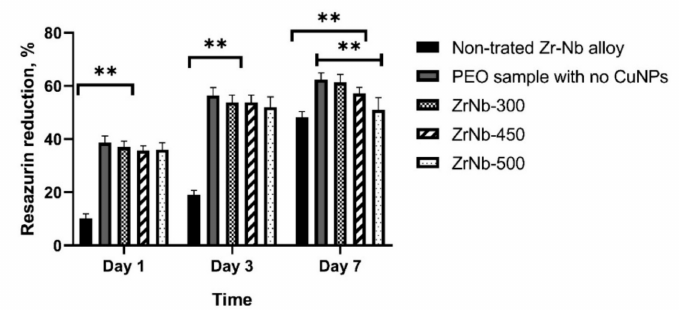
Figure 8. The resazurin reduction assay test at di ff erent times of osteoblast cultivation in ZrNb samples with PEO in di ff erent voltage modes. Asterisks indicate the p value between groups: **— p < 0.001.